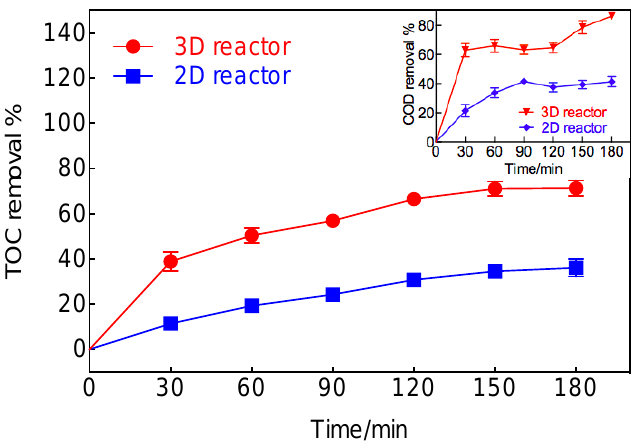
Figure 2. Total organic carbon (TOC) and chemical oxygen demand (COD) removal of rhodamine B (RhB) wastewater in the recycling-flow 3D and 2D electro-reactor systems (RhB wastewater initial concentration is 100 mg/L; volume is 500 mL; initial pH is 7; Na 2 SO 4 as an electrolyte, initial concentration is 2 g/L; voltage is 5 V; hydraulic retention time (HRT) is 20 min).